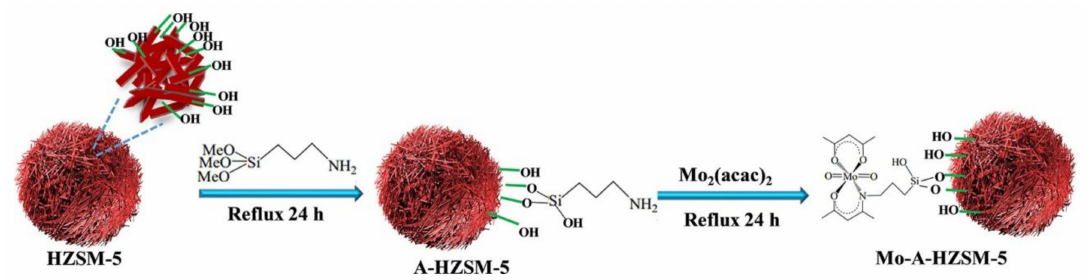
Figure 22. Schematic representation of Mo-A-HZSM-5 synthesis. Reproduced with permission from Reference [48]. Copyright (2021), Wiley-VCH